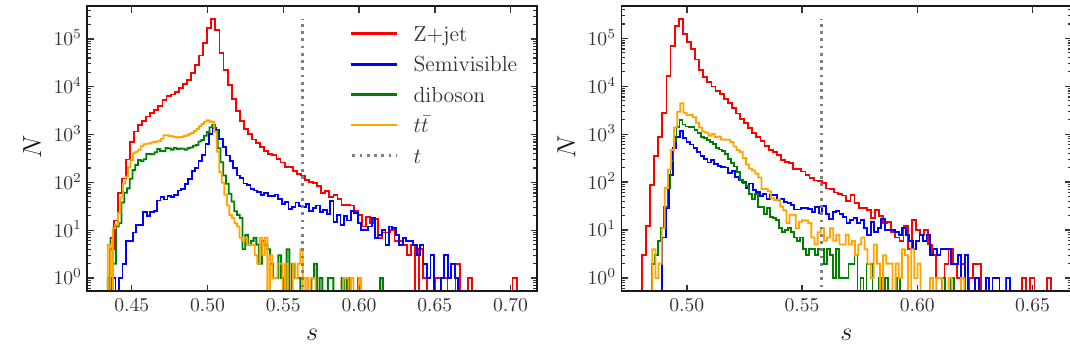
Figure 3 . Same as figure 2 but for overestimated (left) additional backgrounds in the control region ( r CR = 5 . 0% and r CR = 3 . 0% ) and underestimated (right) additional backgrounds ( r CR V V t ¯ t and r CR = 1 . 6% ). We also show the threshold value t for (cid:15) CR = 0 . 001 as a vertical V V